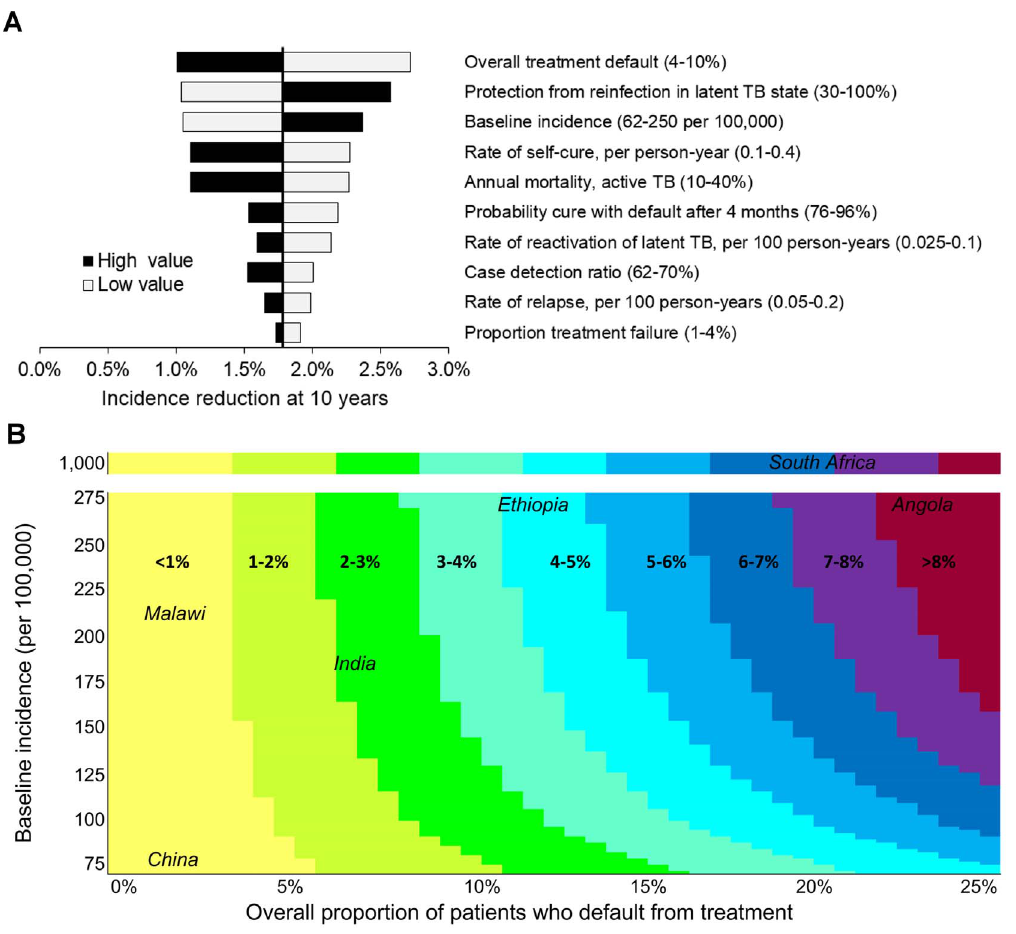
Figure 4. Sensitivity analyses. One-way and two-way sensitivity analyses of the difference in incidence at year 10 after introduction of a four- month regimen versus continuation of a six-month regimen of equal efficacy. A) One-way sensitivity analyses. Input parameters were varied one at a time within ranges consistent with estimates in the literature (Table 2). In this figure, we varied incidence by varying the transmission rate, but no major differences were observed when we instead varied the proportion of rapid progression to active disease. The parameters that most significantly influenced the impact of a four-month vs. six-month treatment regimen were the degree of protection afforded by latent infection, incidence of TB disease, and the proportion of treated patients who default at baseline. B) Two-way sensitivity analysis. The two most influential parameters likely to vary widely across epidemiological settings (TB disease incidence and proportion of treated patients defaulting at baseline) were varied simultaneously in a stepwise manner, within a range consistent with estimates in the literature and various epidemiologic settings (Table 2). Colors correspond to the range of projected incidence reduction for each combination of baseline incidence and treatment default and selected countries with representative estimates are shown. The highest estimates for both treatment default (25%) and baseline incidence (1,000 per 100,000/year) resulted in no more than 8.3% incidence reduction with a four-month vs. six-month regimen at 10 years.